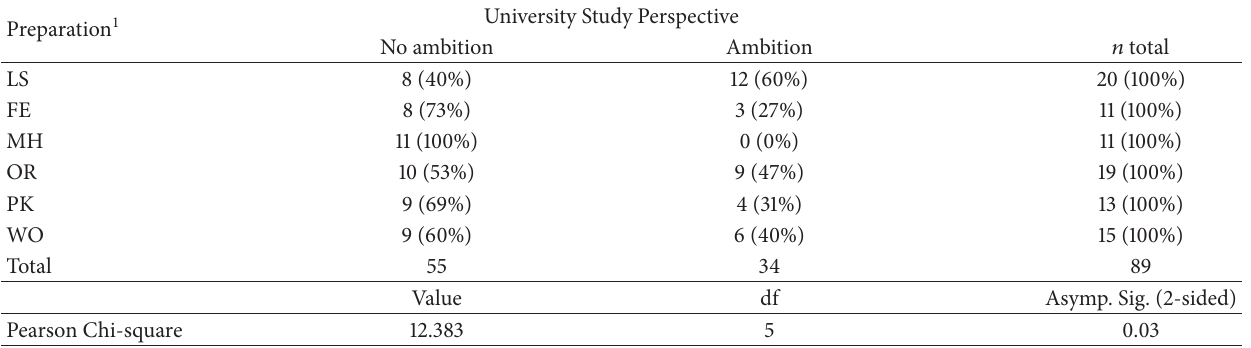
Table 10: The relation between the intention to switch to the university and the types of preparation ( 𝑛 = 89 ). Preparation